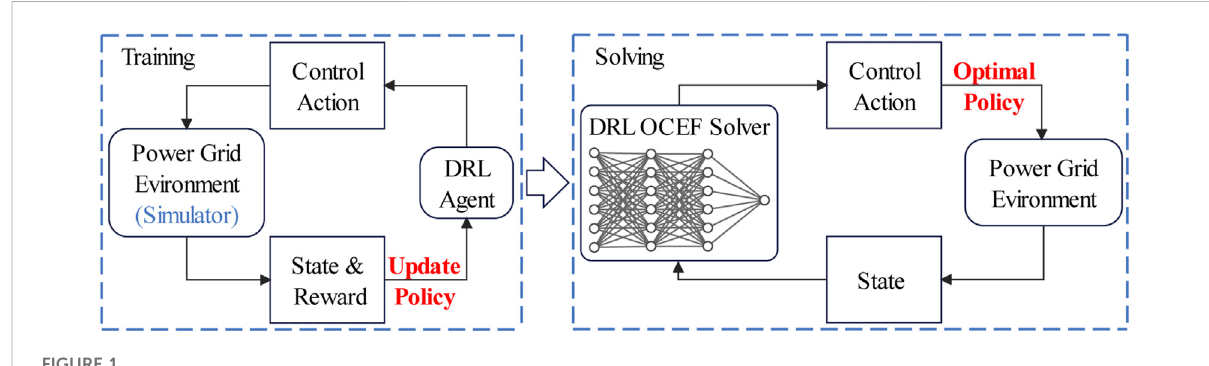
FIGURE 1 The DRL-based framework to solve the OCEF